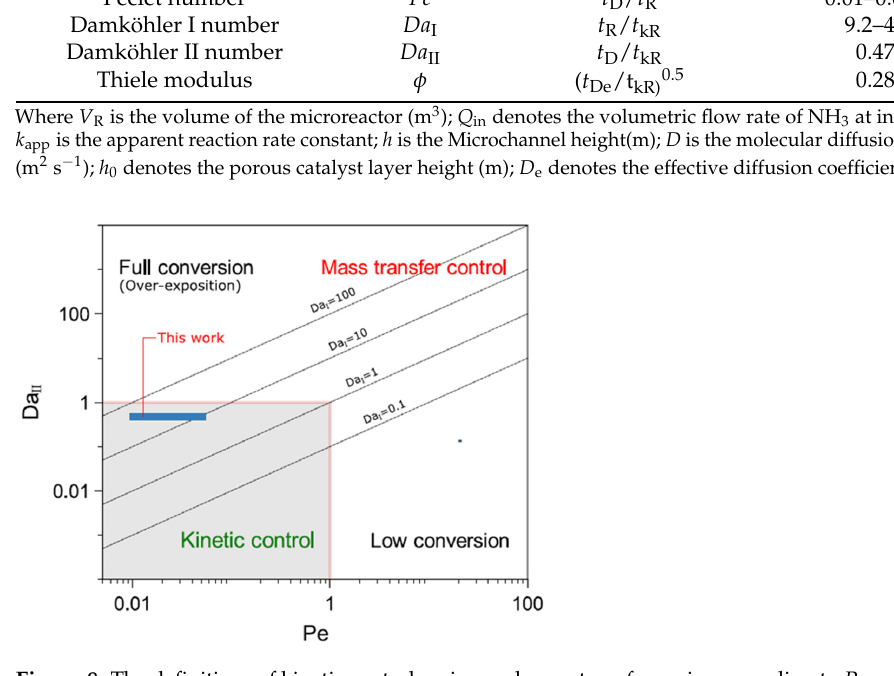
Figure 8. The definitions of kinetic control region and mass transfer region according to 𝑃𝑒 and 𝐷𝑎 II